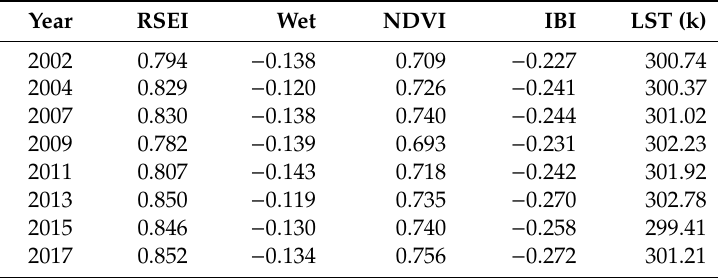
Table 3. Means of RSEI and four